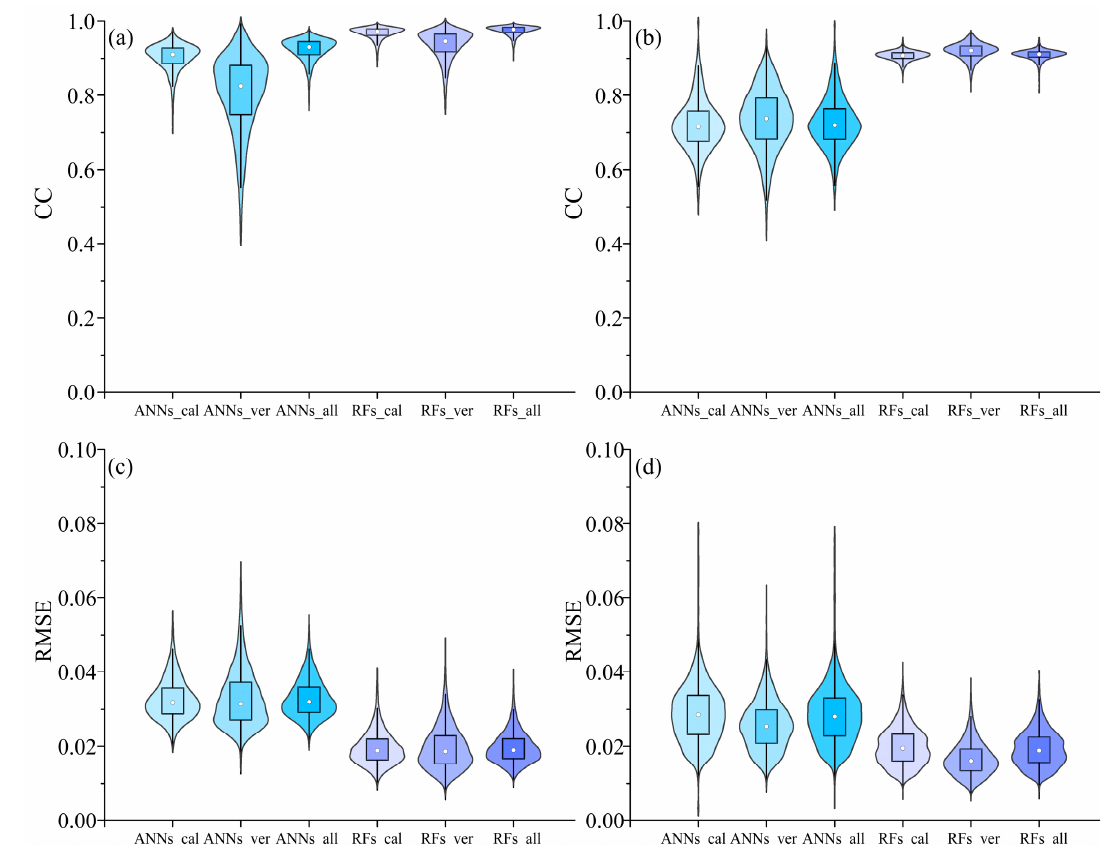
Figure 4. Comparison of reconstructed soil moisture series in different scenarios against original ESA CCI SM series. ( a , b ) are the CC values for the spatial and temporal domains, respectively, and ( c , d ) are corresponding RMSE